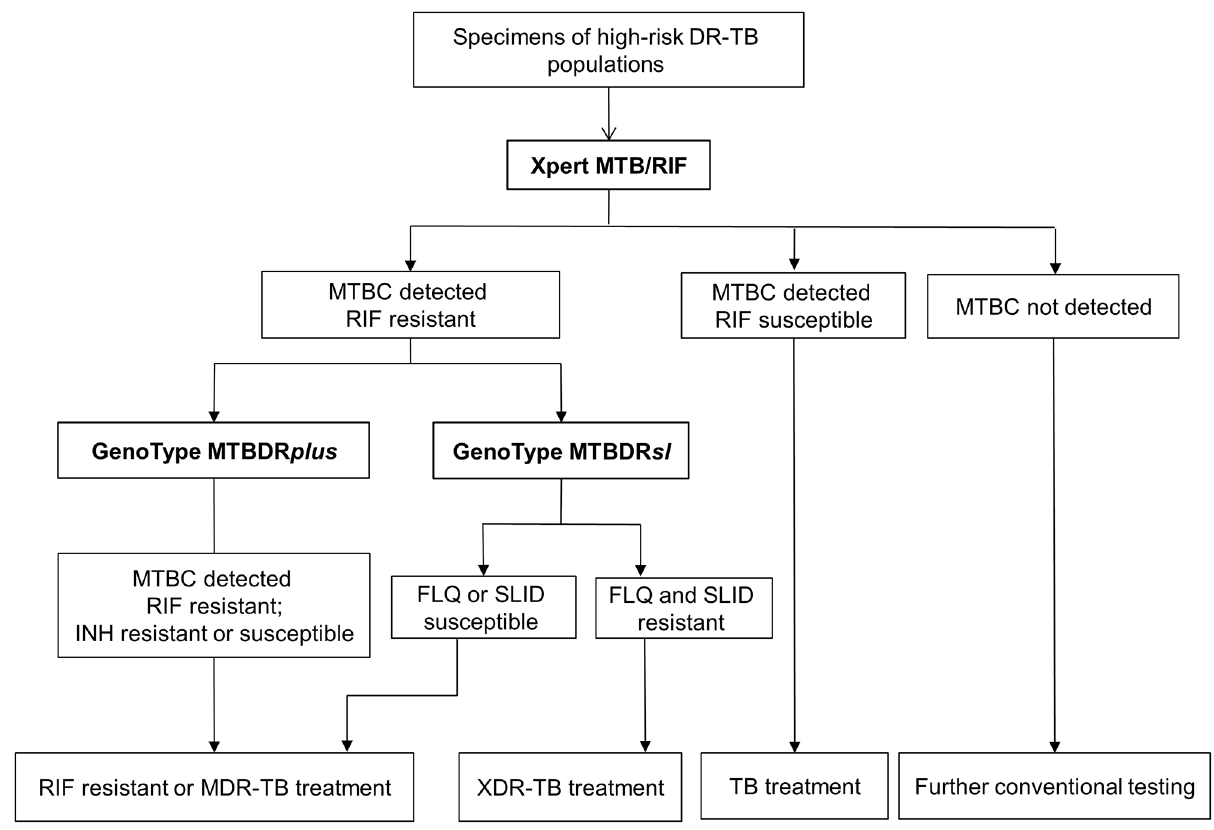
Fig 1. An Xpert-based algorithm for diagnosing DR-TB among high-risk populations.